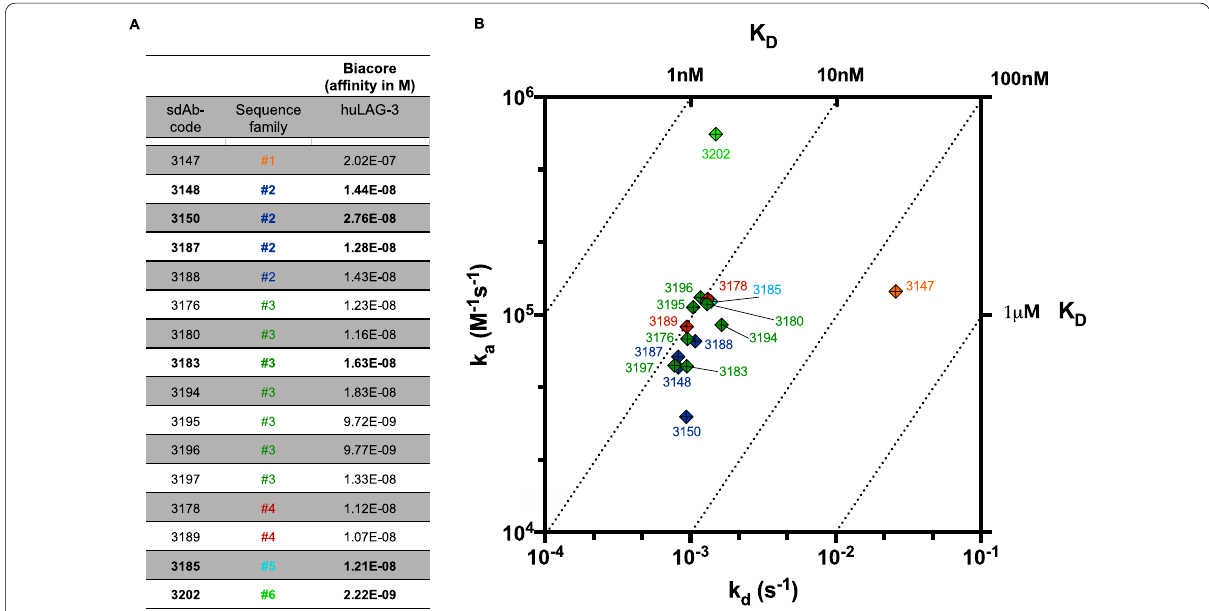
Fig. 1 SPR analysis of anti-huLAG-3 sdAbs. A The table shows the code, sequence family and affinity of the sixteen selected sdAbs as determined by SPR on immobilized huLAG-3-Fc. B RaPID plot illustrating the association ( k a ) and dissociation ( k d ) values for each of the sdAbs, determined via affinity analysis using the biacore T100 instrument. Each sdAb, color-coded for family-homology, is indicated as a dot on the two-dimensional graph so that pairings with identical affinity ( K D ) values are located along iso-affinity